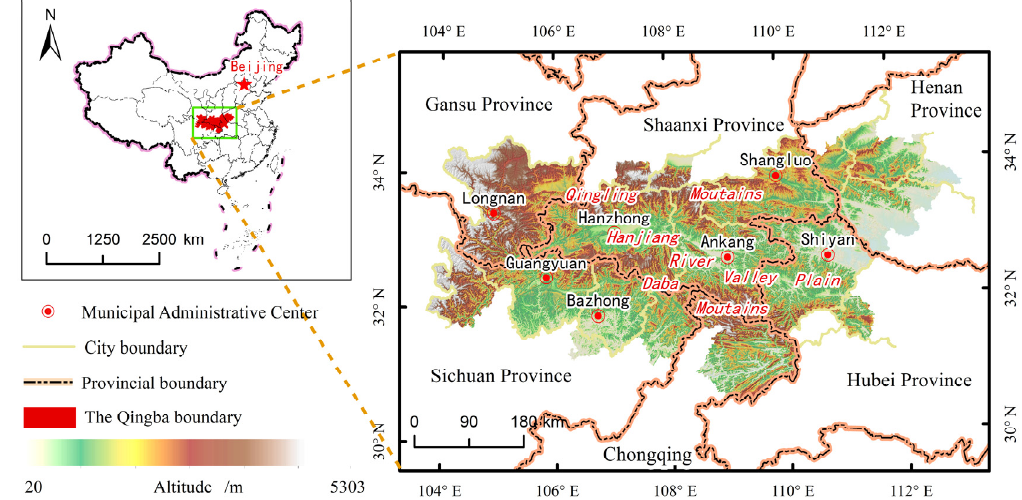
Figure 1. Map of the Qinba Mountains (QBM).